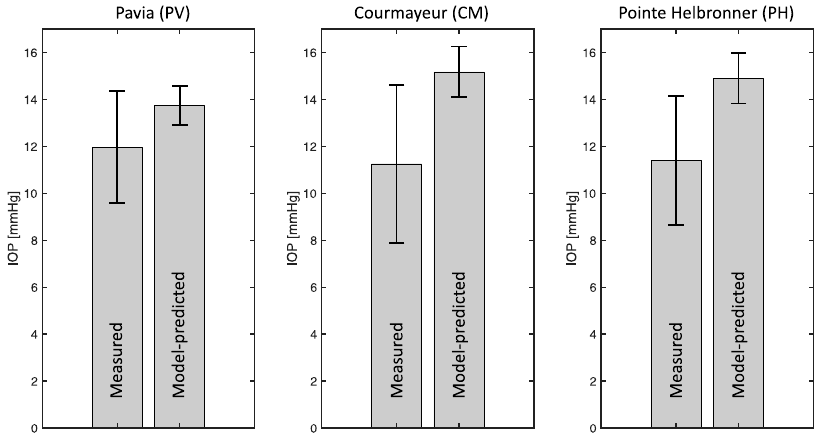
Figure 6. The physiology − enhanced intraocular pressure analysis shows that changes in mean arterial pressure are not sufficient to explain the measured intraocular pressure (IOP) differences at different altitudes, since the measured IOP decreases with altitude while the model predicted IOP increases. Attribution: Guidoboni, G.; Szopos, M.; Verticchio Vercellin, A.C.; Bruttini C.; Riva, I.; Siesky, B.A.; Harris A.; Quaranta L. Physiology-enhanced data analytics to evaluate the effect of altitude on intraocular pressure. Investigative Ophthalmology & Visual Science June 2021, Vol.62, 559